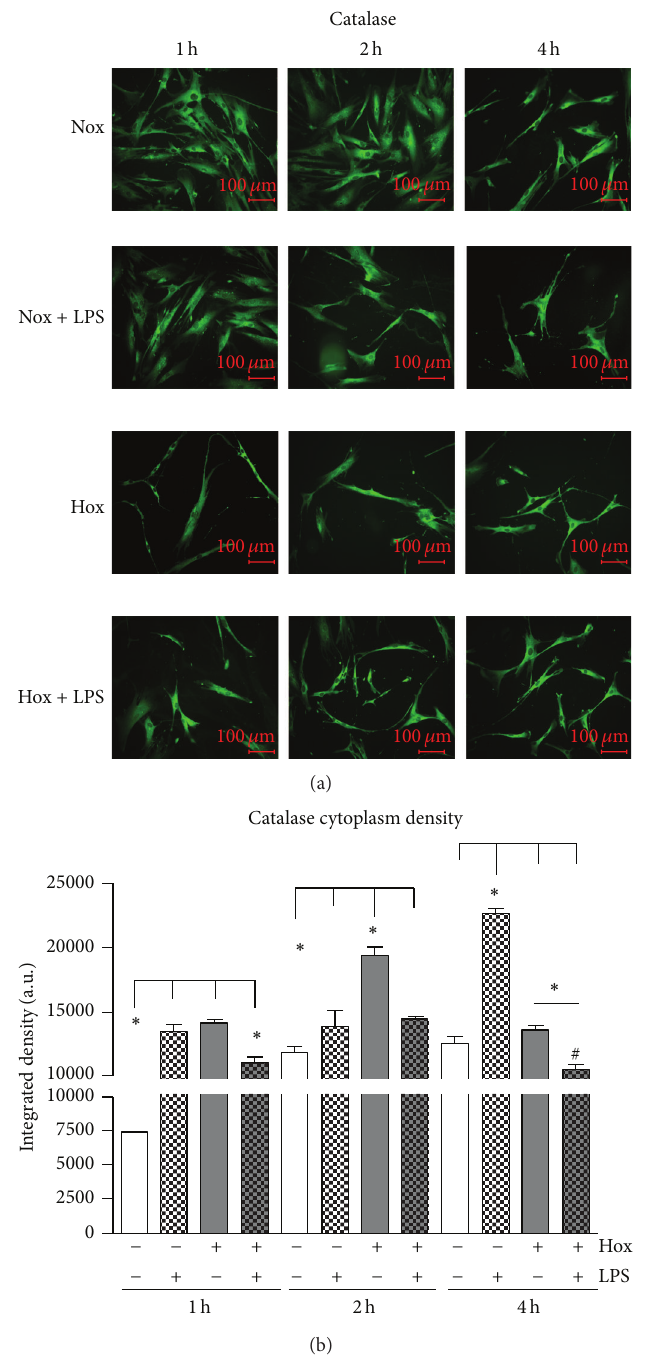
Figure 3: Catalase (CAT) in PDL cells. (a) CAT was visualized by immunofluorescence staining (1: 50; antibody from Abcam). PDL cells were cultured under normoxic (Nox) or hypoxic condition (Hox) and stimulated with or without LPS of Porphyromonas gingivalis (1 𝜇 g/mL). Catalase cytoplasm density (b) was determined in relation to cell area using the freely available image-processing software ImageJ 1.43 (http://rsb.info.nih.gov/ij/). Statistical analysis of immunofluorescence data was analyzed by one-way ANOVA and post hoc Dunnett and Tukey’s multiple comparison test; # 𝑃 < 0.05 difference to control; ∗ 𝑃 < 0.05 difference between groups (means ± SD; 𝑛 = 6 ). The scale bars indicate 100 𝜇 m in the immunofluorescence